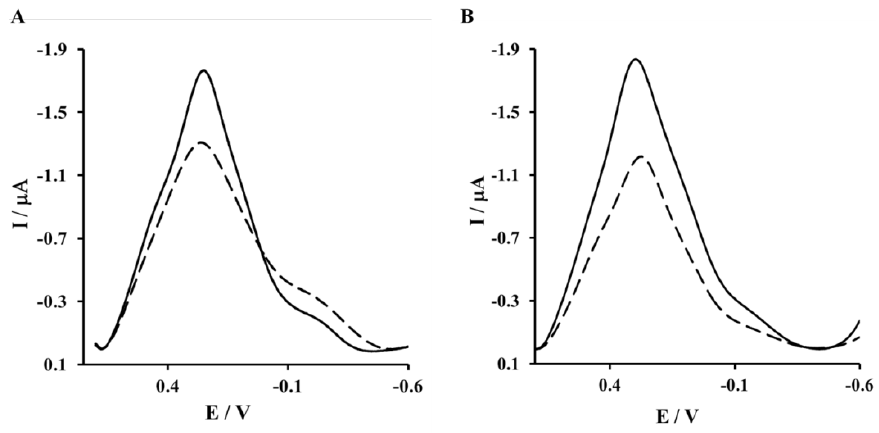
Figure 4. Square wave voltammograms of a gold electrode modified by NAC/ DPTA-Cu(II) (solid line) and NAC/DPTA-Cu(II)-His ( A ) RAGE V natural domain; ( B ) RAGE V mutated domain. Measurement conditions: 0.1 M KCl, scan rate100 mVs −1